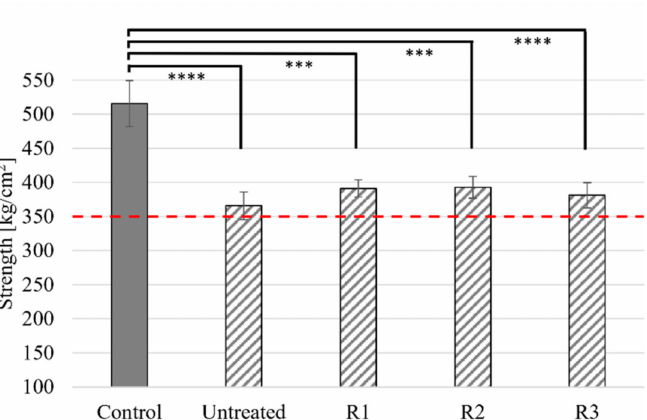
Figure 19. Compressive strength of mortars with 5% replacement rubber addition, grain size T1, using cement C1, after 28 days. *** ( p < 0.001); **** ( p <